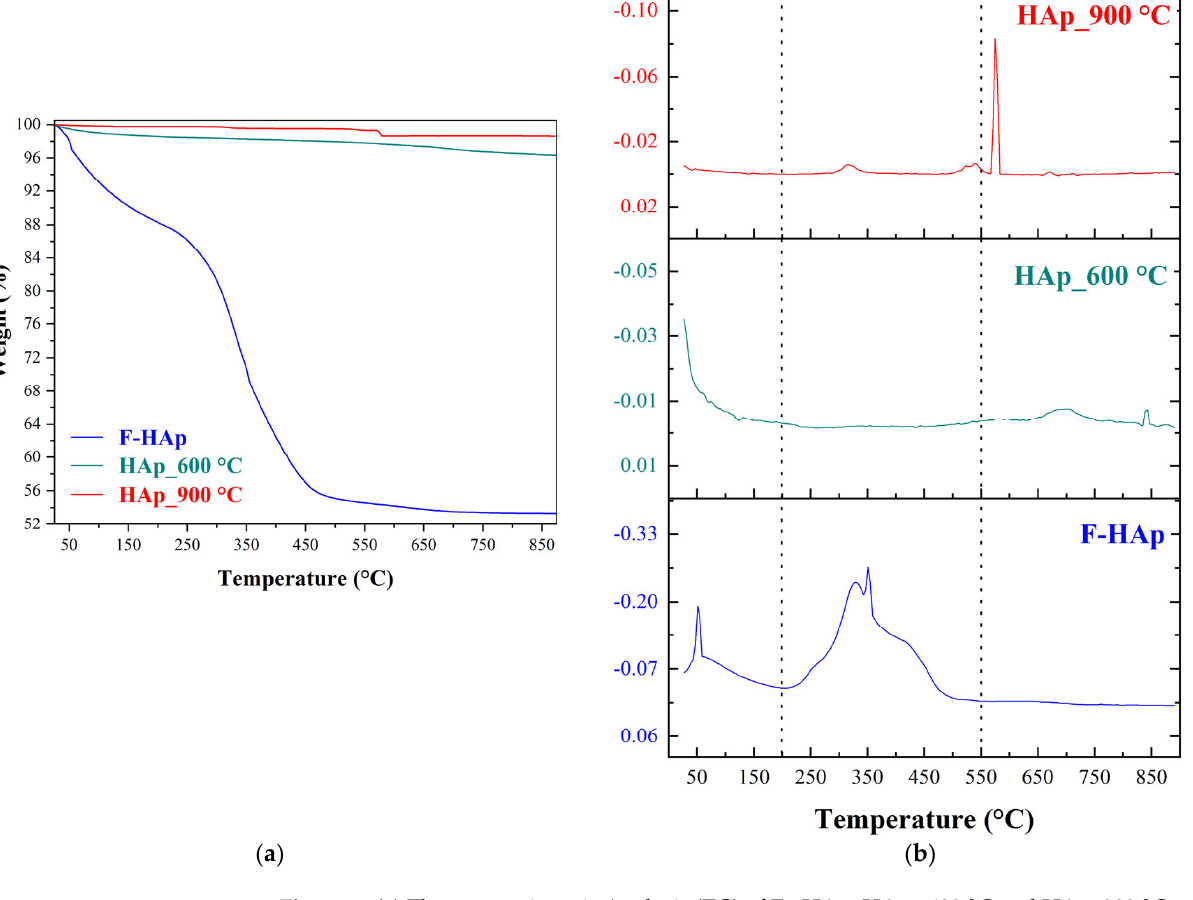
Table 5. Weight loss of each reported thermal event (thermogravimetric analysis).